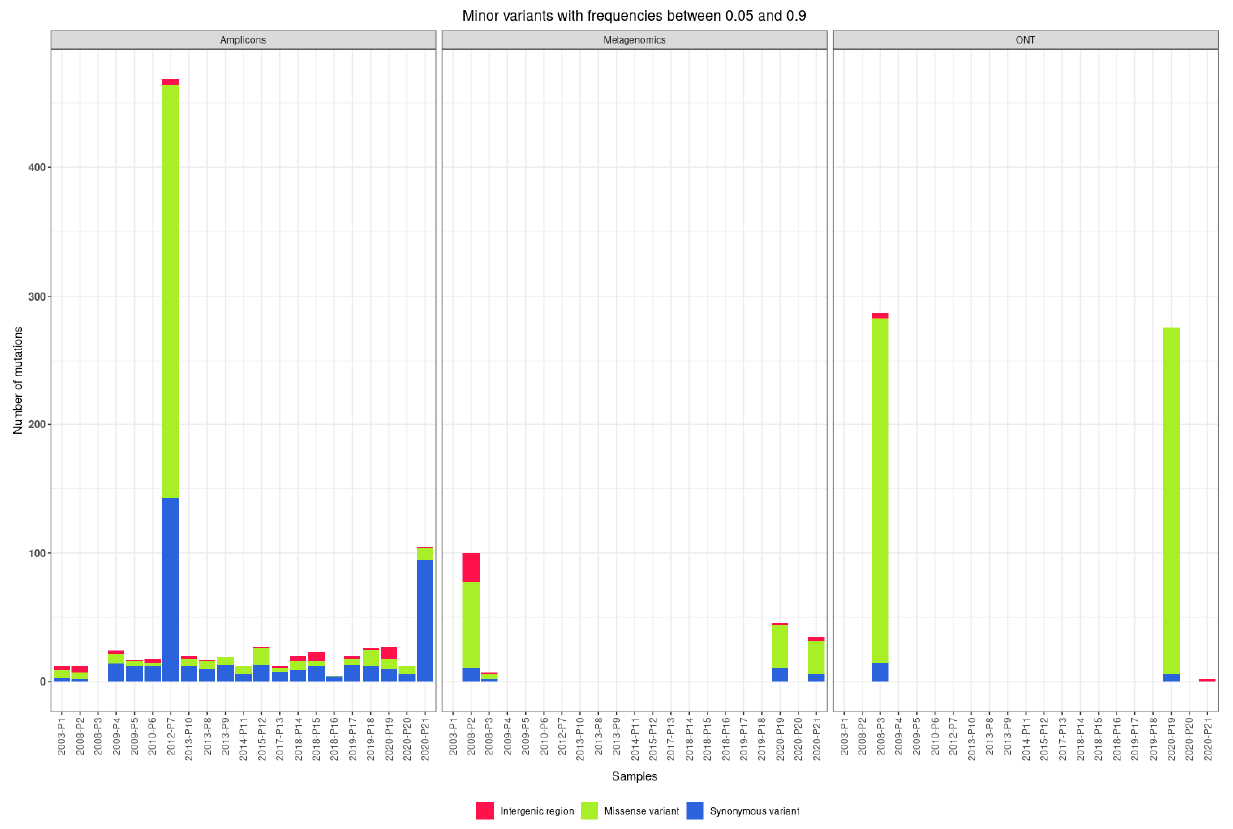
Figure 5. Number of different quasispecies variants found in the sequenced TBEV genomes sequenced with amplicon-based and shotgun metagenomic sequencing on Illumina and Oxford Nanopore Technologies platforms.